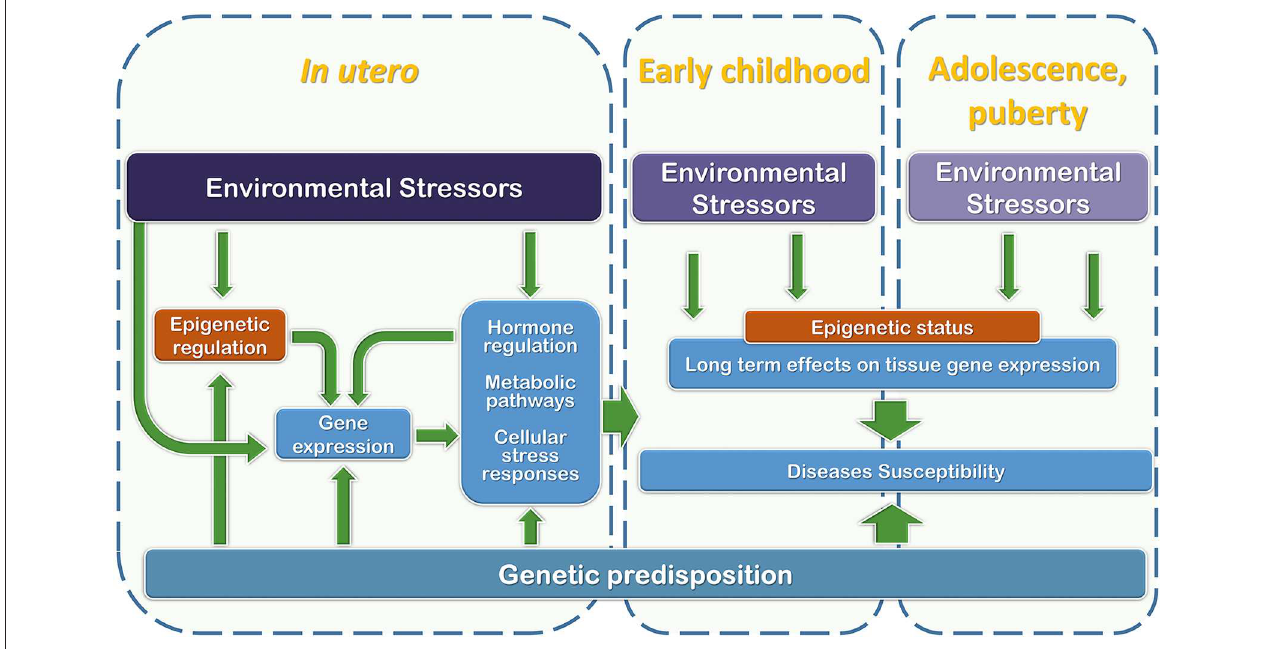
FIGURE 2 | Graphical representation of the relationships among development phases, genetic predisposition, and environmental stressor factors that may interfere with regulatory mechanisms during the early stages of life (from in utero development to